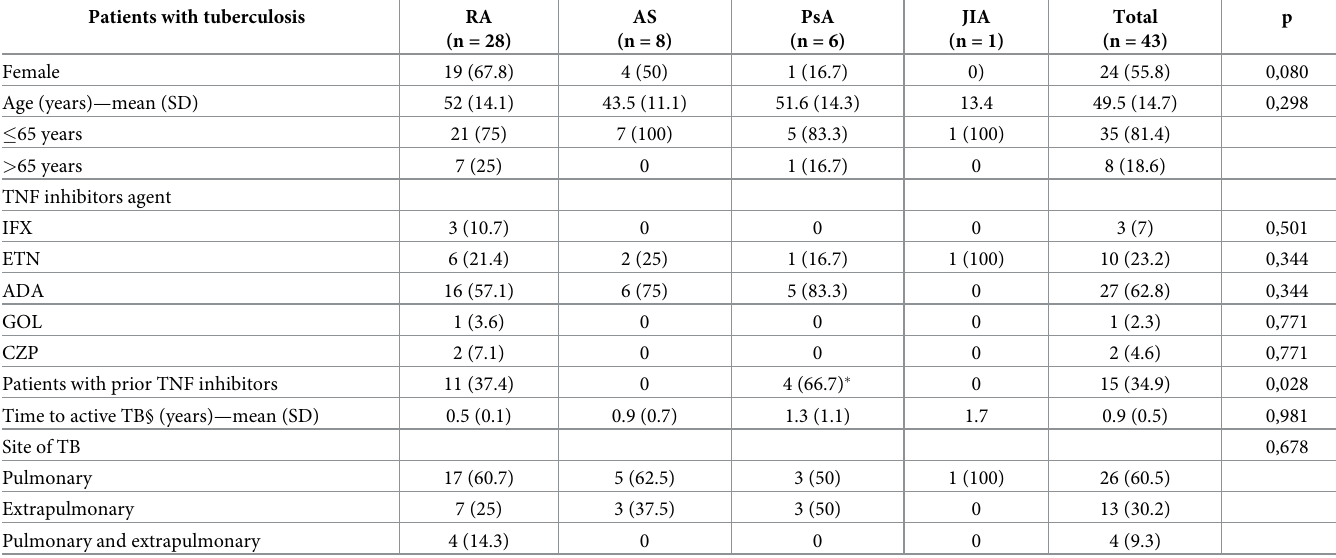
Table 2. Demographic and clinical features in patients with tuberculosis.